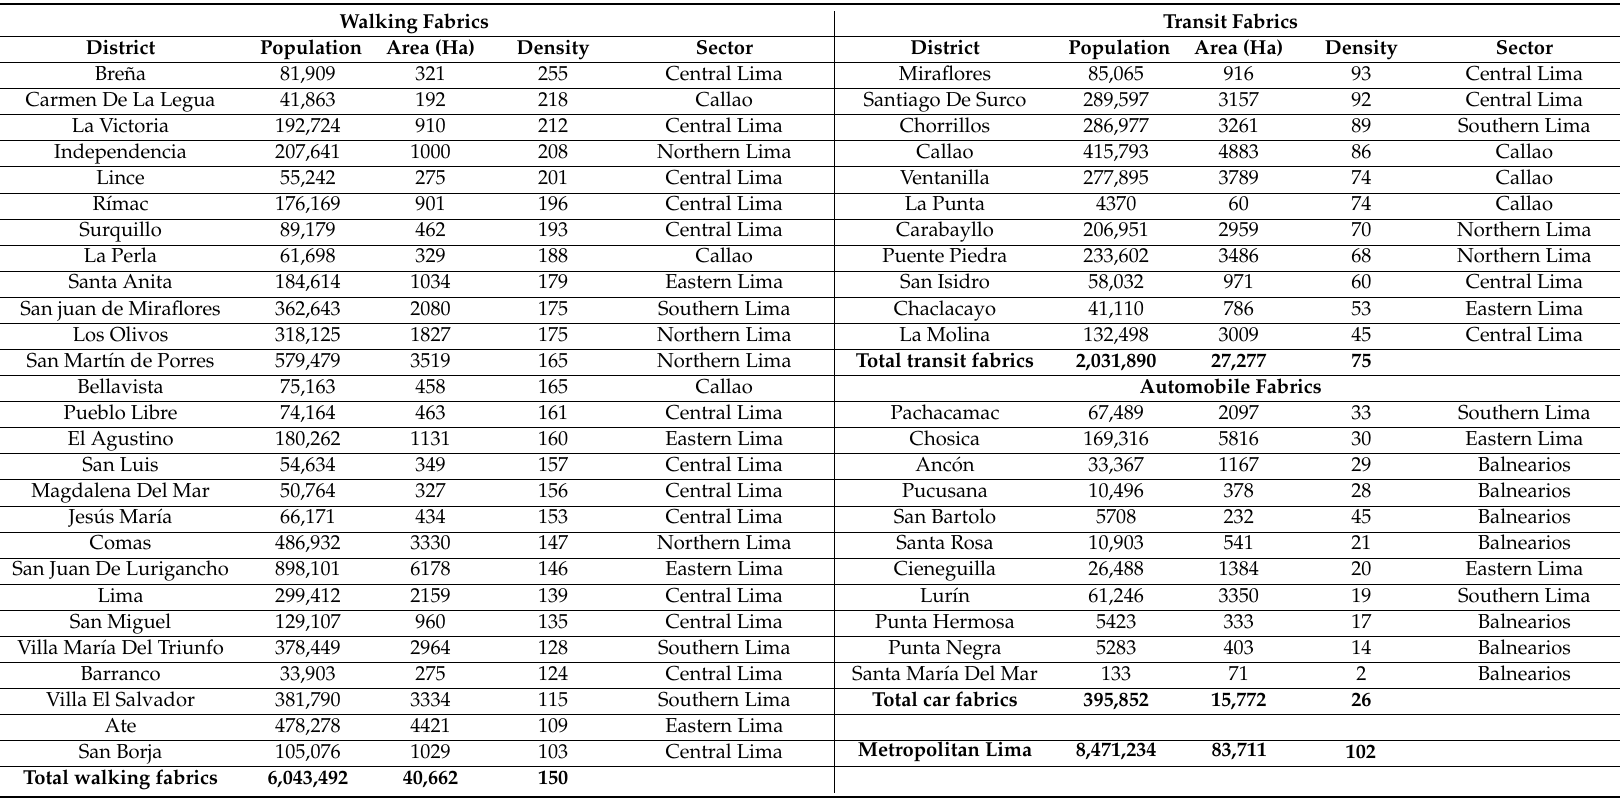
Table 3. Categorization of Lima’s Districts into Walking, Transit, and Automobile fabrics according to their density in 2010. Walking Fabrics Transit